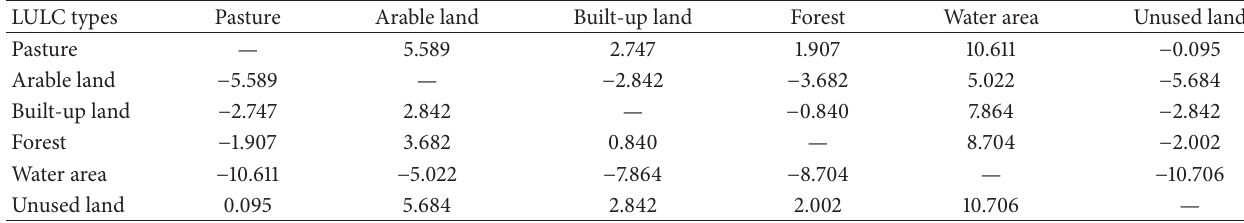
Table 3: The difference matrix of EC coefficients among different LULC types.